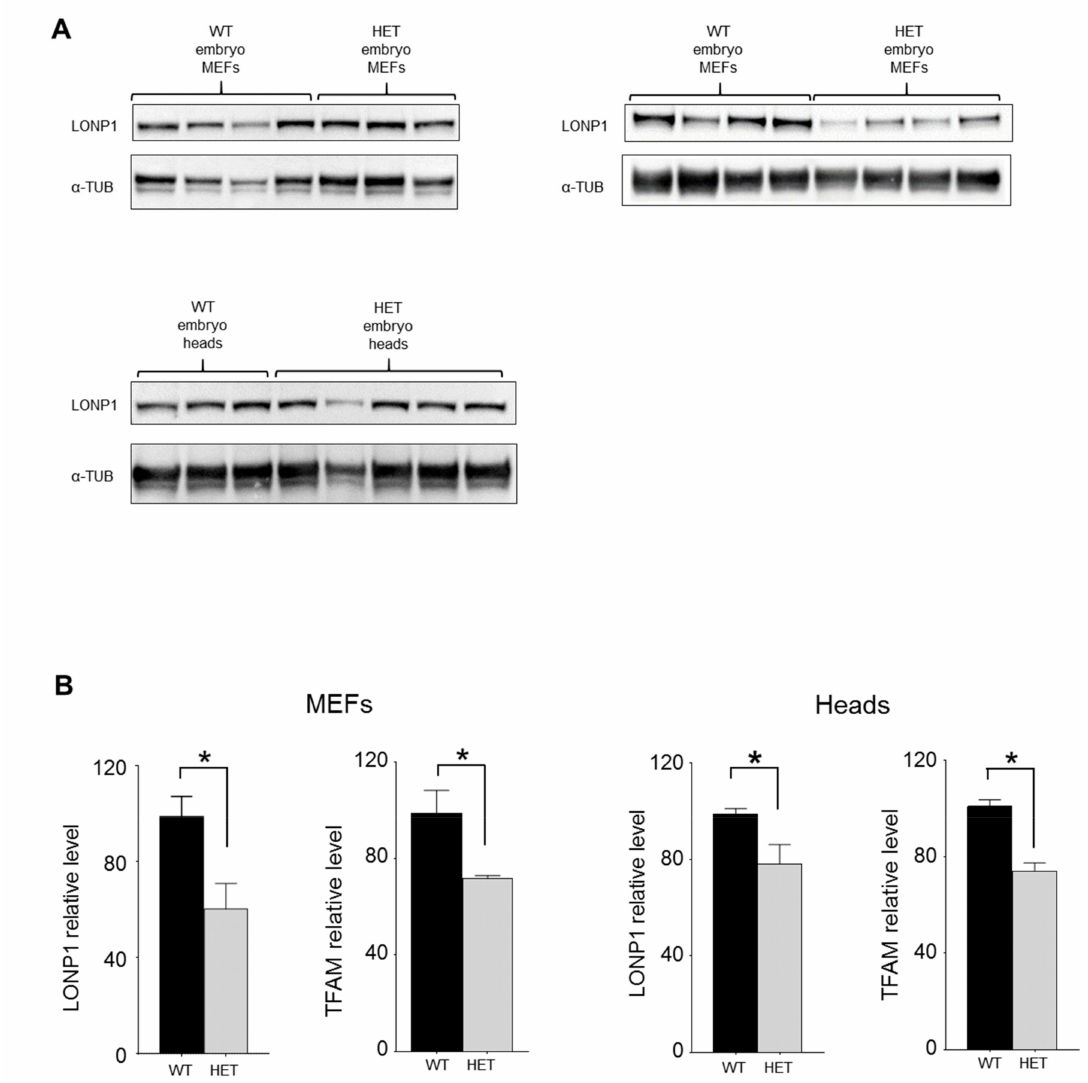
Figure 6. LONP1 and TFAM protein expression in heads of embryos and in MEFs. ( A ) Western blot analysis of LONP1 expression in heads of embryos and in MEFs. ( B ) Relative protein level of LONP1 and TFAM in heads of embryos and in MEFs. n = 3 or more. Data are expressed as mean ± SEM. * p <